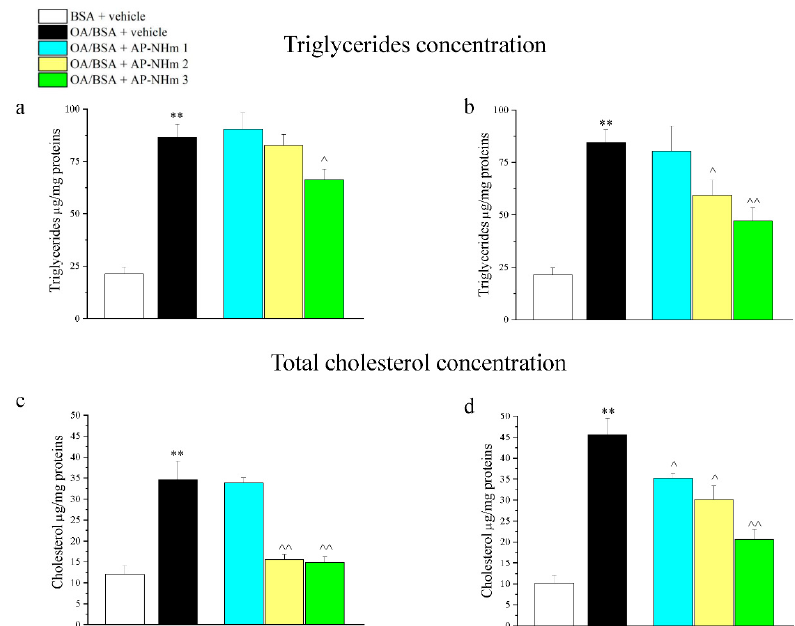
Figure 3. E ff ects of AP-NHm on dyslipidemias: intracellular triglyceride concentration in co-treatment ( a ) and post-injury ( b ) regimens; total cholesterol concentration in co-treatment ( c ) and post-injury ( d ) regimens. HepG2 were incubated with 0.5-mM oleic acid in 1% BSA (OA / BSA) or BSA alone for 24 h in co-treatment or in post-injury recovery treatment (48 h) with AP-NHm 1, 2, 3. ** p < 0.01 vs. BSA + vehicle, ˆ p < 0.05 and ˆˆ p < 0.01 vs. OA / BSA + vehicle. Nutrients 2020 , 12 , x FOR PEER REVIEW